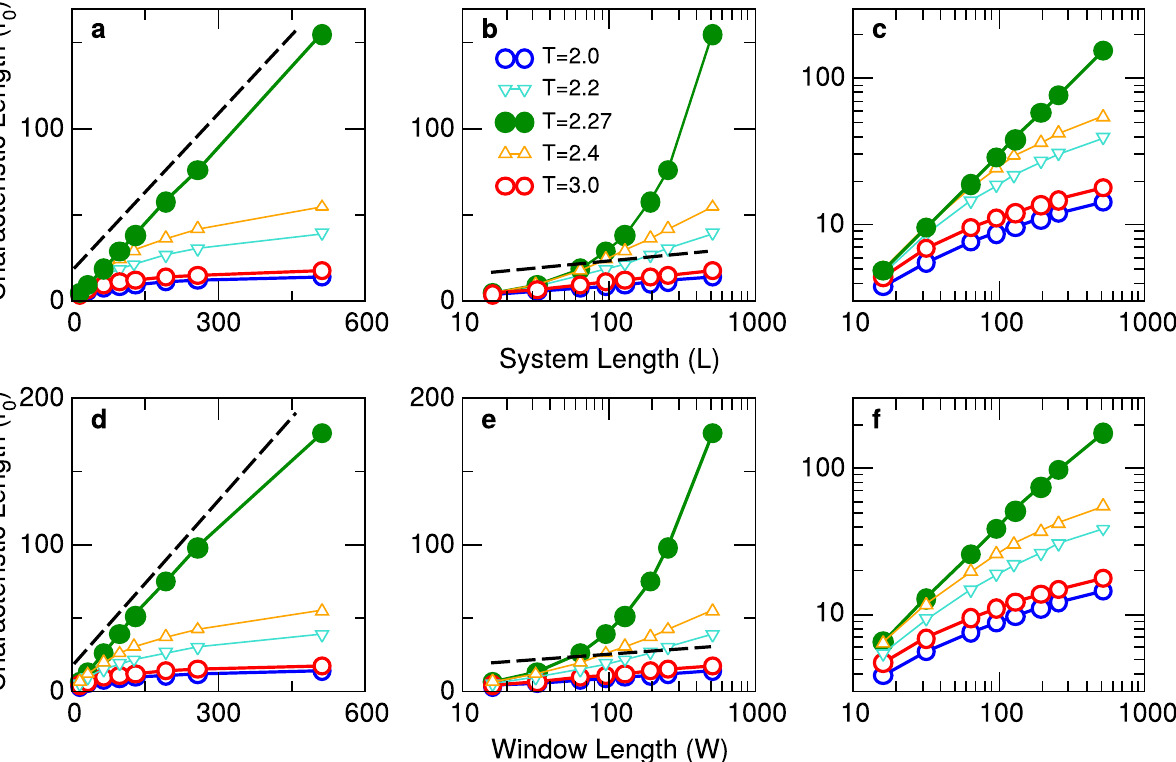
Figure 4. Characteristic length r 0 of the ferromagnetic 2D Ising model. The zero crossings of the computed CCF are plotted in linear–linear (left), log–linear (middle) and log–log (right) axis. Top three panels correspond to different system sizes L and bottom three panels to different window lengths W . Different symbols correspond to the values of the temperature T denoted in the legends. Dashed lines are visual aids to emphasize the predicted logarithmic behavior for both sub-critical and super-critical regimes (open circles), and the linear dependence expected for the critical regime (filled circles). Open triangles are used to denote results obtained for intermediate values of temperature indicated in the legend. In all cases, error bars are omitted, since error estimates are smaller than symbol size.